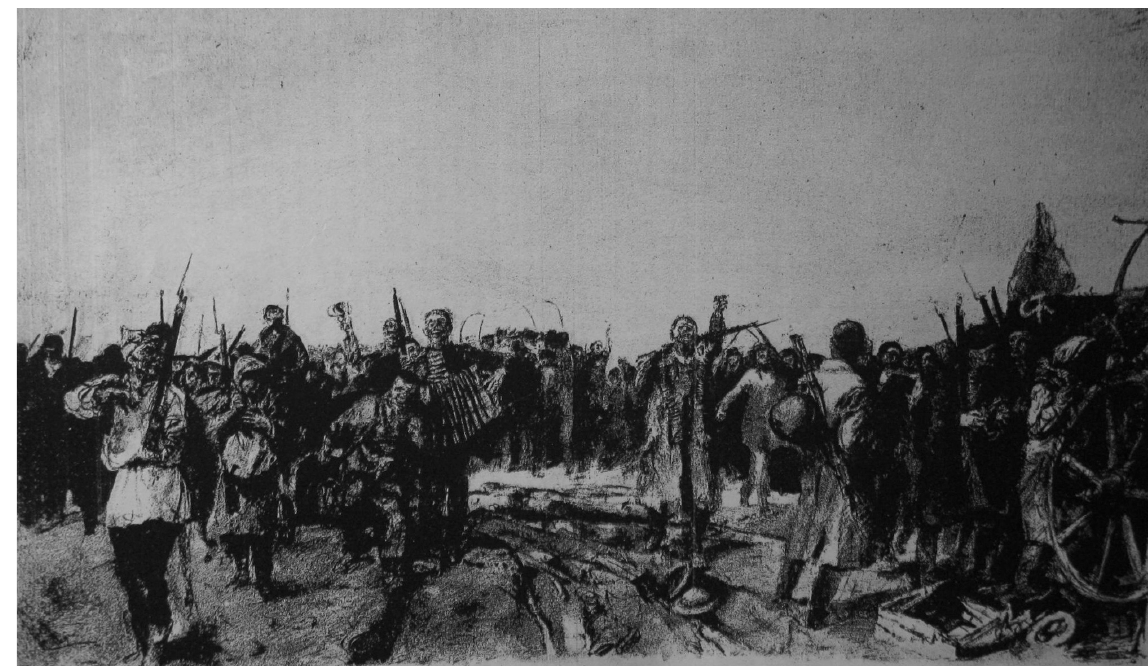
Bernhard Heisig, Peace March , 1957. Lithograph. Size and location